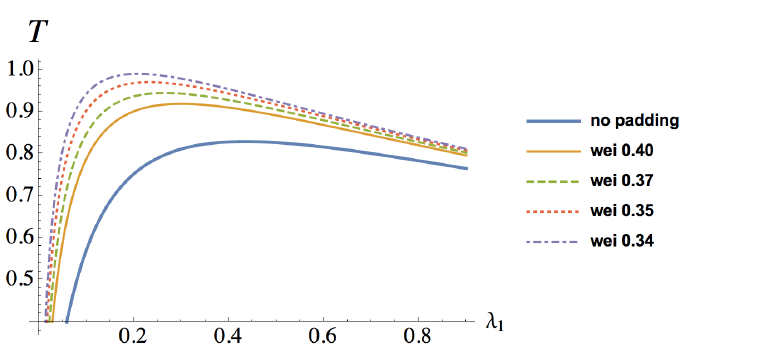
Figure 7. Security and performance tradeoff changing with rekeying rate λ 1